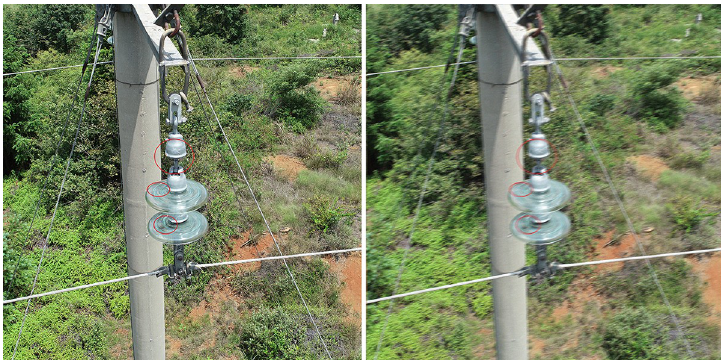
Fig 6. The insulator image after motion blur. (a) The original image, (b) The image after motion blur.